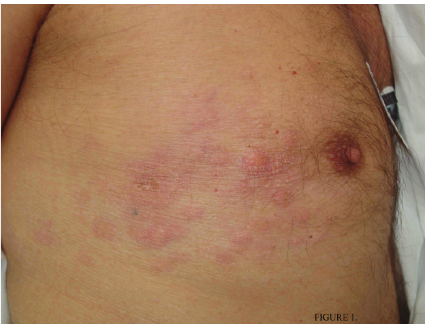
Figure 1: Erythematous nodules following a metameric distribution on the chest.